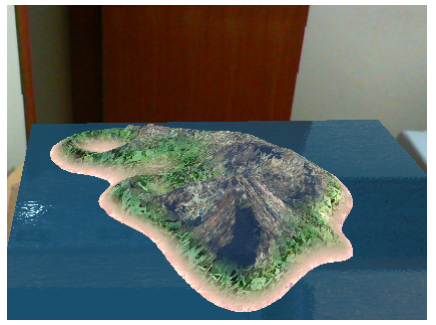
Fig. 14. Another example terrain generated with the